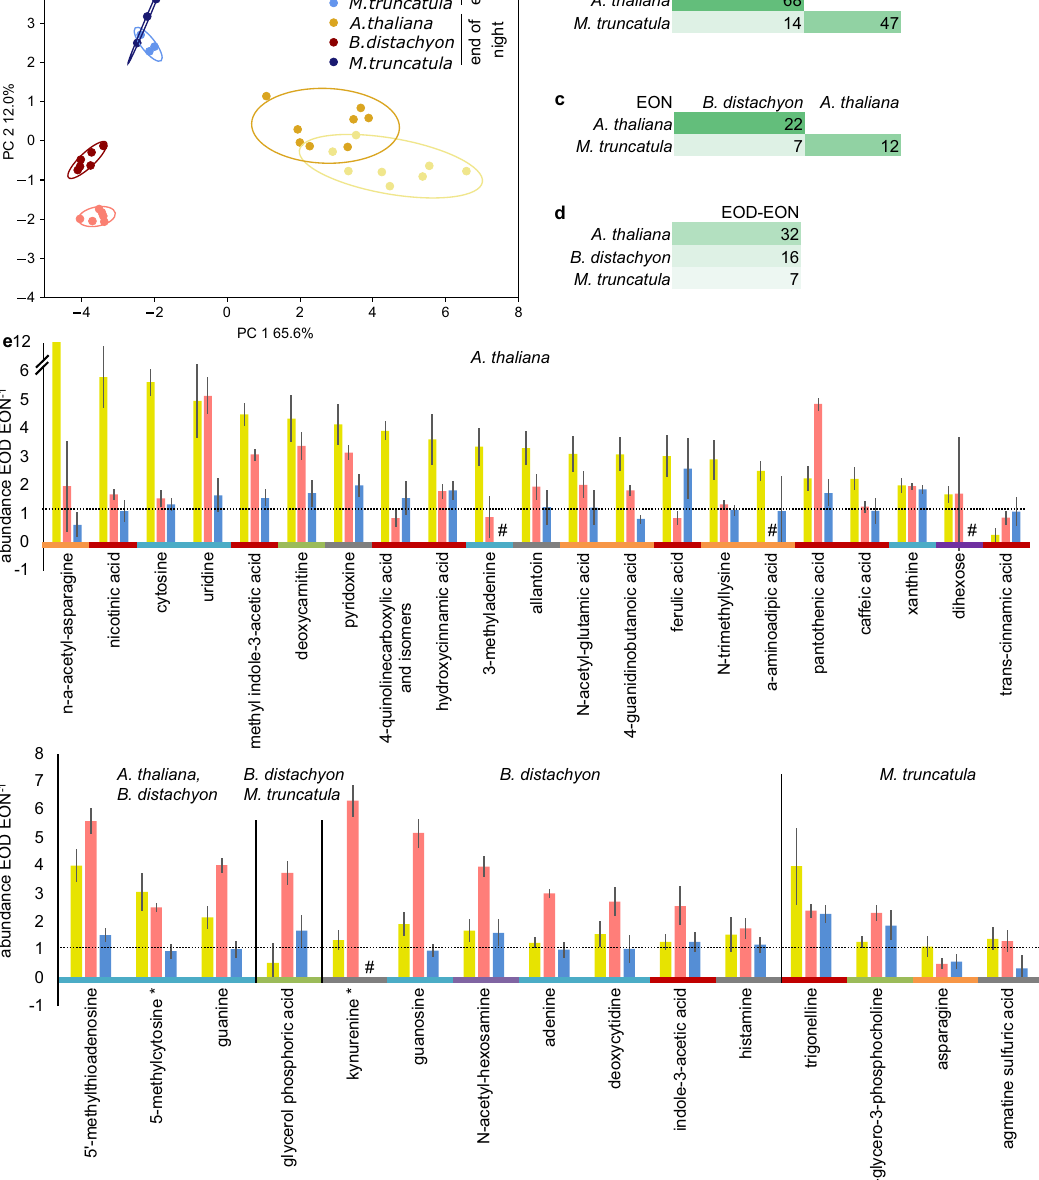
representativeexperimentoutofthreetotalisdisplayed.Compoundsaregrouped by decreasing fold change within one group and are colored by class: